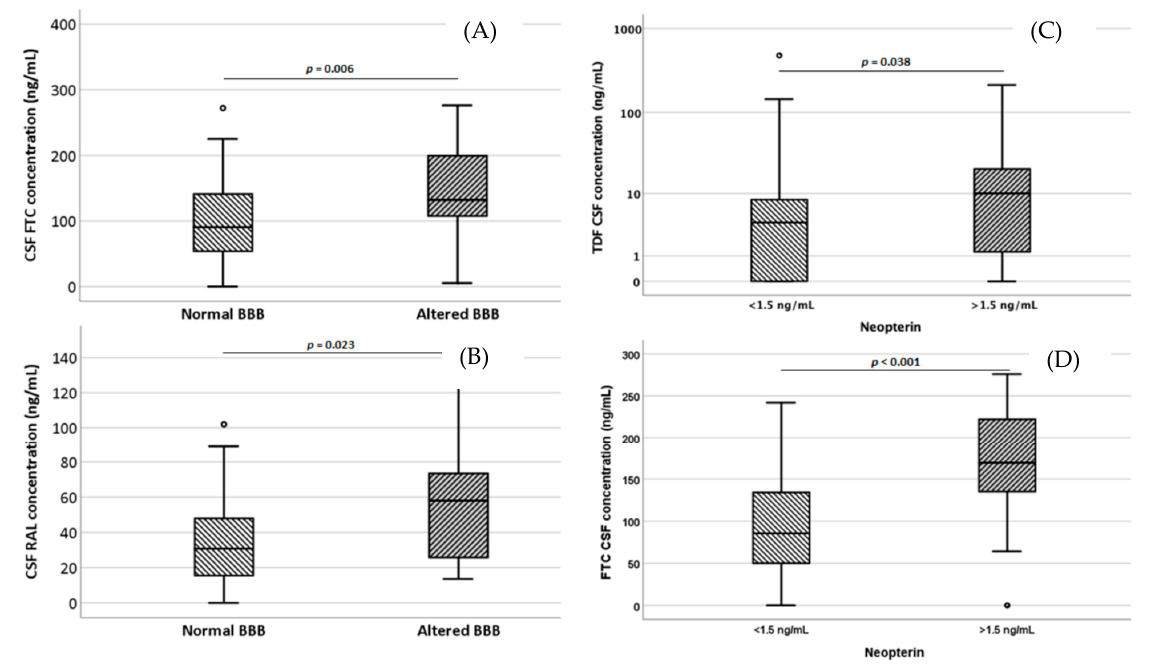
Figure 3. Cerebrospinal fluid according to an altered blood–brain barrier ( A , B ) and increased neopterin levels ( C , D ). FTC: emtricitabine, RAL: raltegravir, TDF: tenofovir. Circles indicate “out” values.